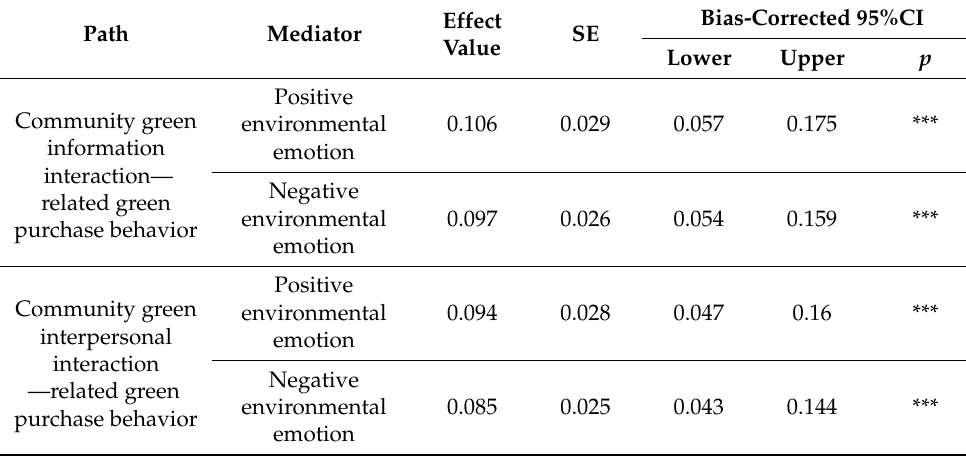
Table 5. Mediating effect test by Bootstrap method.